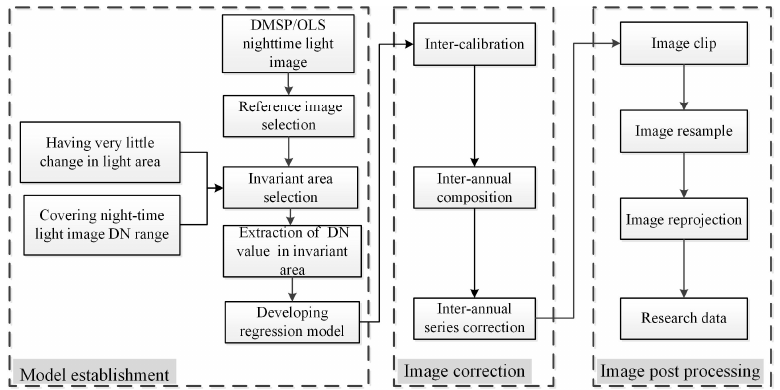
Figure 3. The process flow of DMSP/OLS nighttime light imagery.